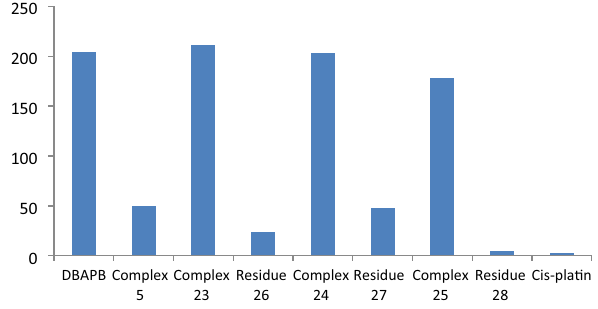
Figure 11. In vitro antitumor activity (IC 50 ) of the ligand, DBAPB, and its Cu(II) complexes and their restudies against HepG-2 cells.